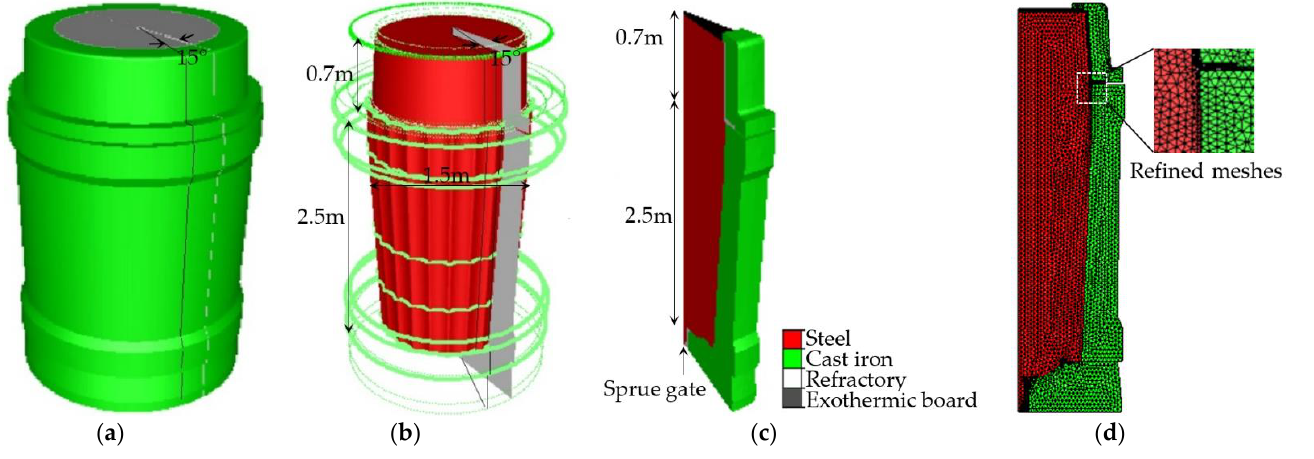
Figure 2. 40 MT casting models established for FE modelling: ( a ) Model established in reference to actual casting system with the segmentation illustration for 1/24 section; ( b ) ingot in the model with transparent mold and segmentation illustration for 1/24 section; ( c ) used 15° model representing 1/24 of casting system; ( d ) meshes used for spatial discretization of the part and mold component.